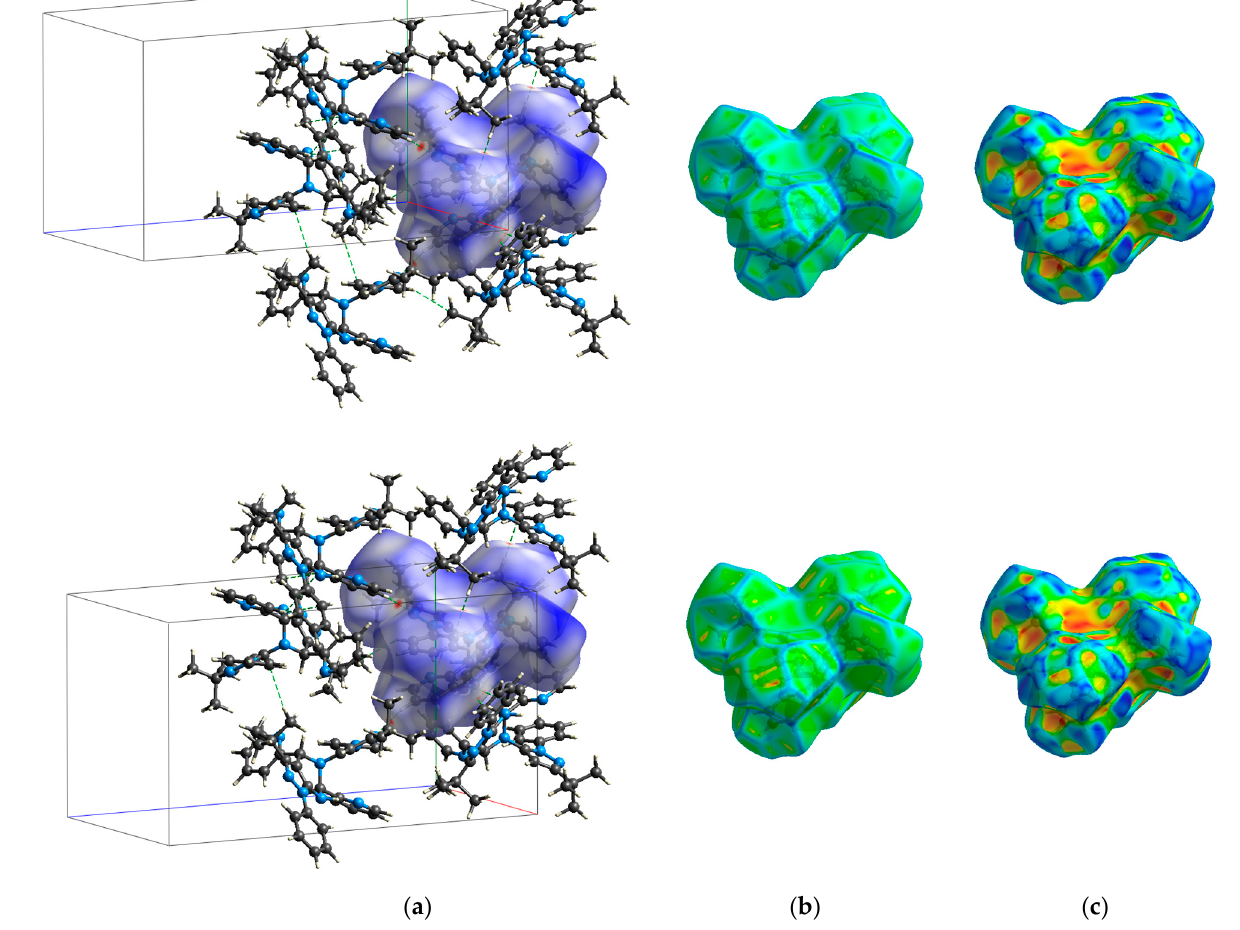
Figure 10. Hirshfeld surfaces (HS) of crystalline molecules 9a (top row) and 9b (bottom row) mapped over ( a ) the normalized contact distance ( d norm ) scaled over the range − 0.08–1.54, ( b ) curvedness ( C ) scaled over the range − 4.0–0.4, and ( c ) shape index ( S ) scaled over the range − 1.0–1.0. Comparison between the 2D-fingerprint plots derived from HSs of polymorphs 9a and 9b (Figure 11) clearly highlights the close—almost identical—distribution of intermolecular interactions shared by these crystal structures. In both crystals, H···H interactions prevail with a coverage of 71.0% ( 9a ) and 71.1% ( 9b ) of the respective HS area. In these FP plots, the small peak centered at d e = d i ≅ 1.1 Å is related to the H···H interaction between an ortho hydrogen in phenyl ring C and a hydrogen atom of the t Bu group linked to pyrazole ring B . C(in)···H(out) interactions are the second intermolecular contribution on HS, with only one decimal percentage higher for 9a (10.9%) than for 9b (10.8%). The interactions H(in)···C(out), N(in)···H(out), and H(in)···N(out) give the same distribution rate in both HSs in a percentage order descending of 8.9, 4.5, and 4.2%, respectively. The narrow spike at d e or d i ≅ 1.1 Å in decomposed N···H FP plots coincides with the interaction marked as a red spot in HS and denoted as (i). Whereas the rounded edges centered on d e or d i ≅ 1.7 Å in decomposed C···H FP plots correspond to the bidirectional π -stacking C···H interaction marked as red spots in HS and denoted as (iii). In the case of the C···C and N···C/C···H interactions, each of them provides only 0.2% of the interatomic contacts across the HS in 9a or 9b .